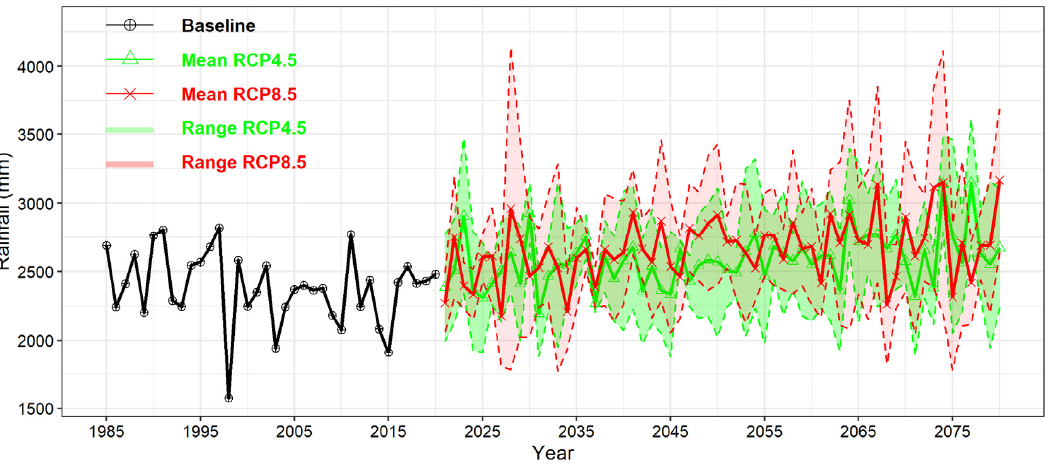
Figure 6. Baseline and projected mean annual rainfall for RCP4.5 and RCP8.5 scenarios in the SRB.